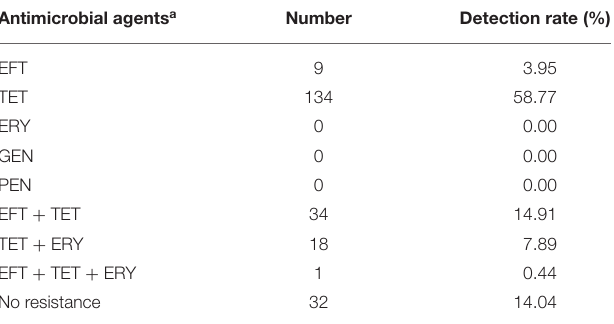
TABLE 4 | Distribution of antimicrobial resistance patterns among Streptococcus uberis ( n = 228) isolates from dairy cattle with bovine mastitis in northern Thailand during 2010–2017.